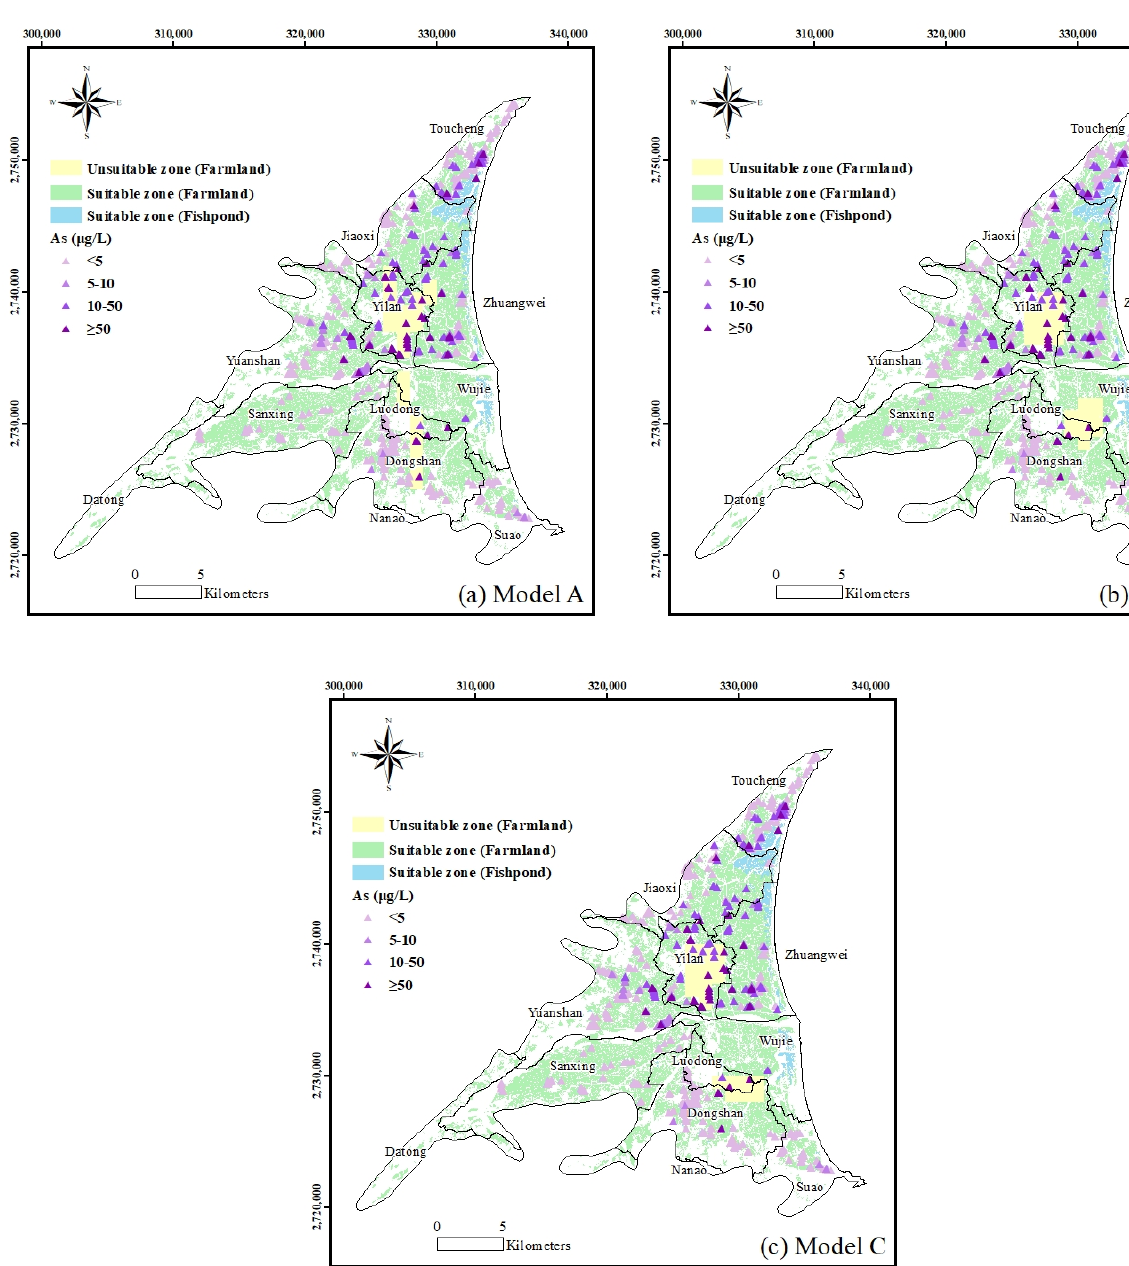
Figure 7. Spatial mapping of the irrigation and aquaculture zones.